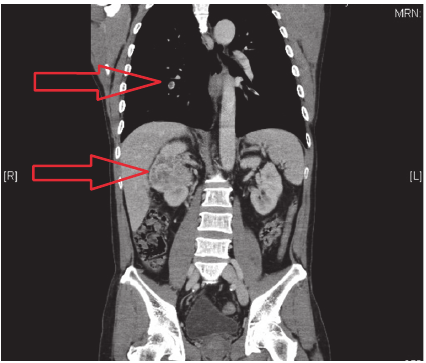
Figure 1: Right renal interpolar tumour with bilateral pulmonary metastases, worse on the right side.